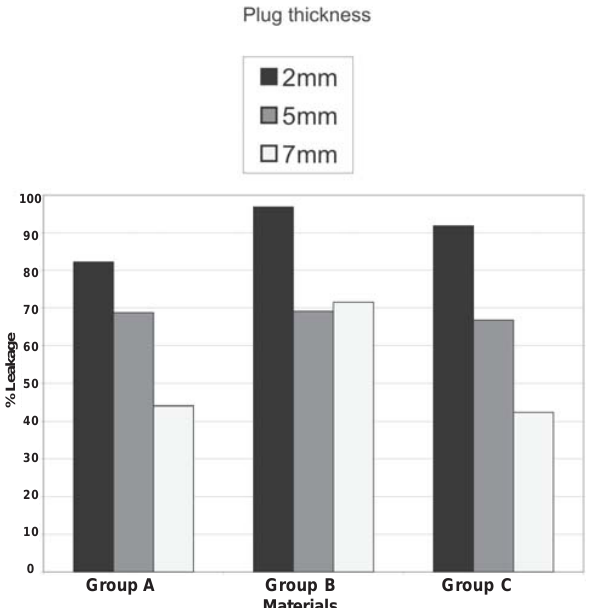
Group A Group B Group C FIGURE 1- Marginal leakage (%) of 0.2% Rhodamine B in root canals according to the materials utilized and plug thickness